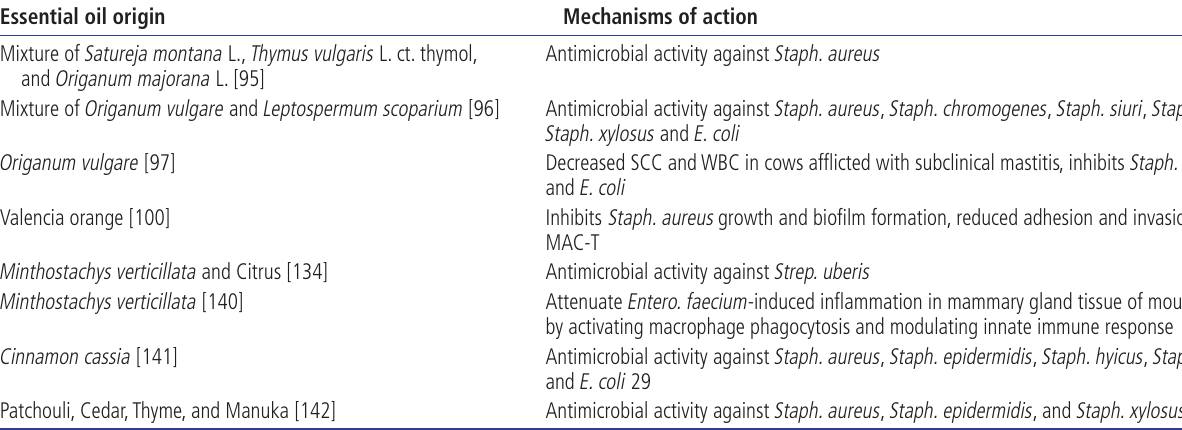
Table 2. Recent studies on plant essential oils against bovine mastitis Essential oil